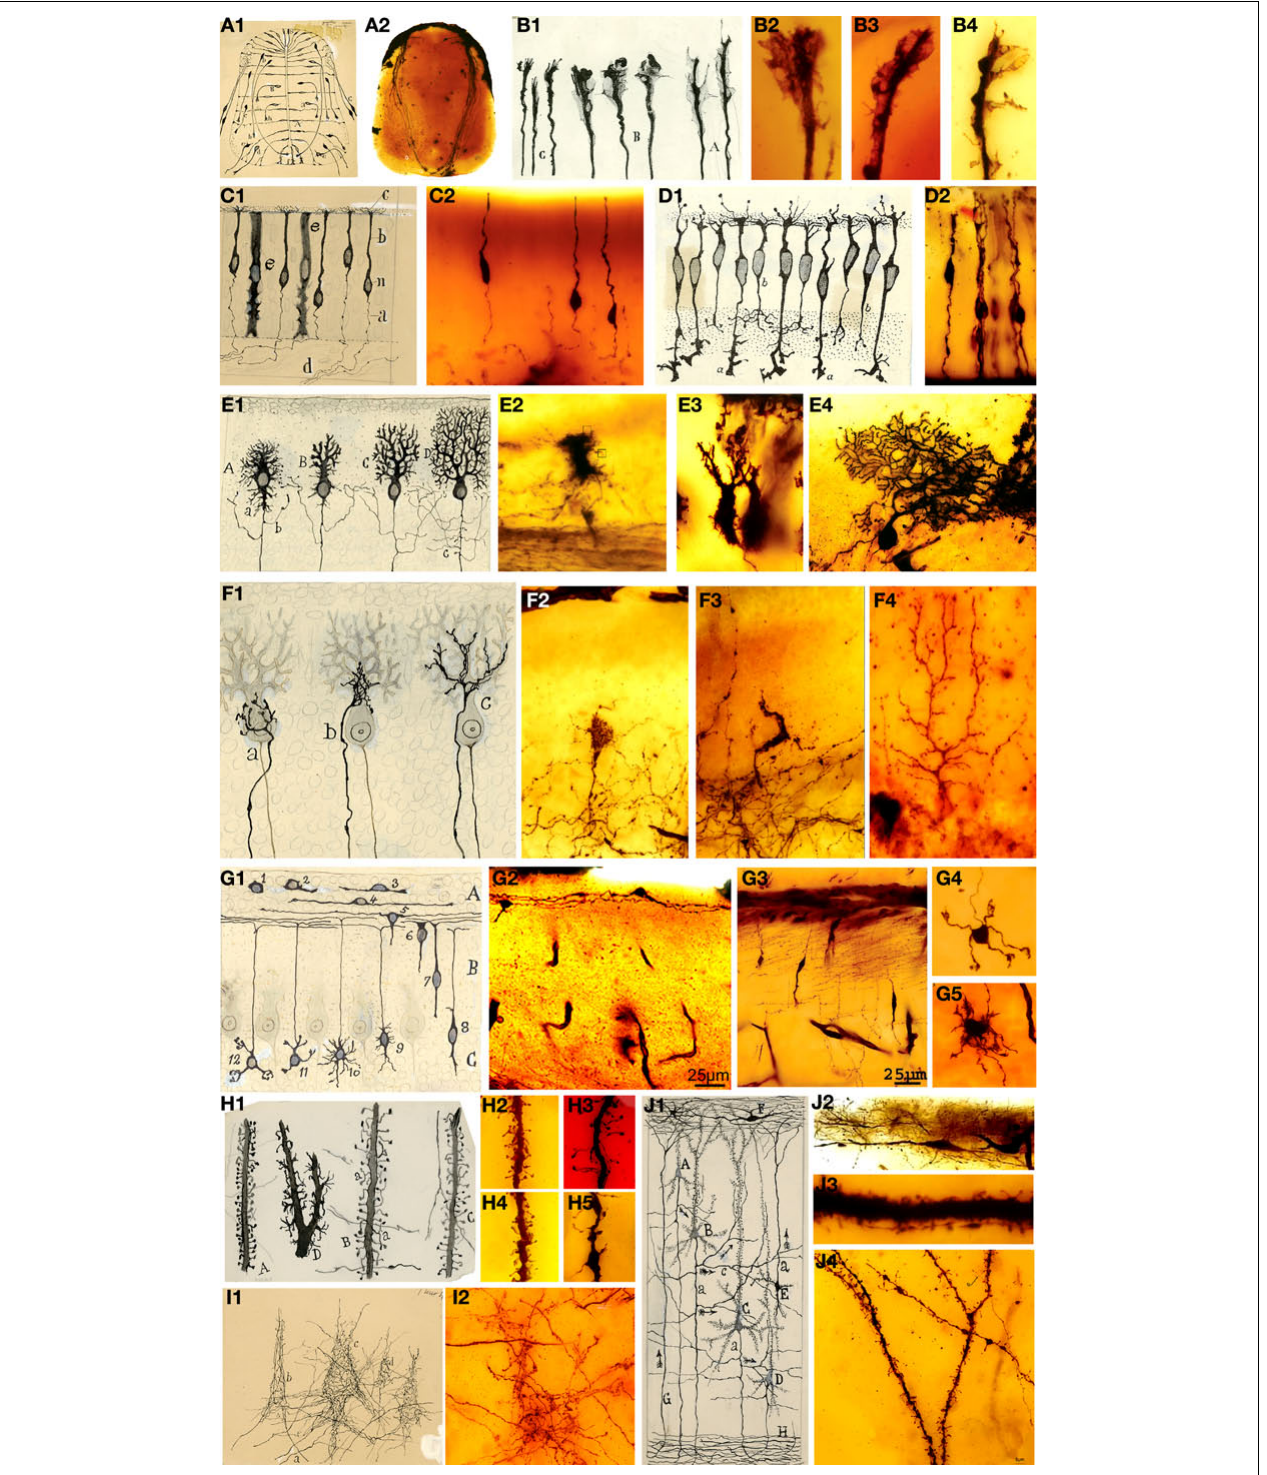
FIGURE 3 | Cajal´s histological preparations and drawings showing some of his most important discoveries with the Golgi Method. (A) Chicken spinal cord; (B) 3 day-old chicken growth cones; (C) Cells from the olfactory mucosa; (D) Bipolar cells (for rods and cones) from the retina of cat; (E) Development of Purkinje cells in bird; (F) Climbing fi ber (pericellular nest stage), newborn dog; (G)